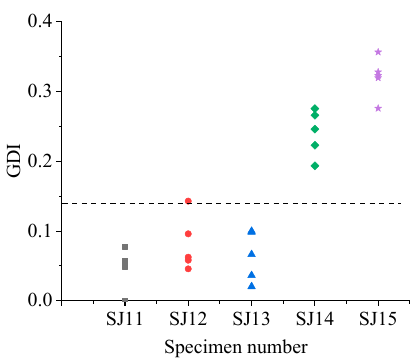
Sensors 2019 , 19 , x FOR PEER REVIEW Figure 11. GDI of specimens in the SJ1 group. Figure 11. GDI of specimens in the SJ1 group.